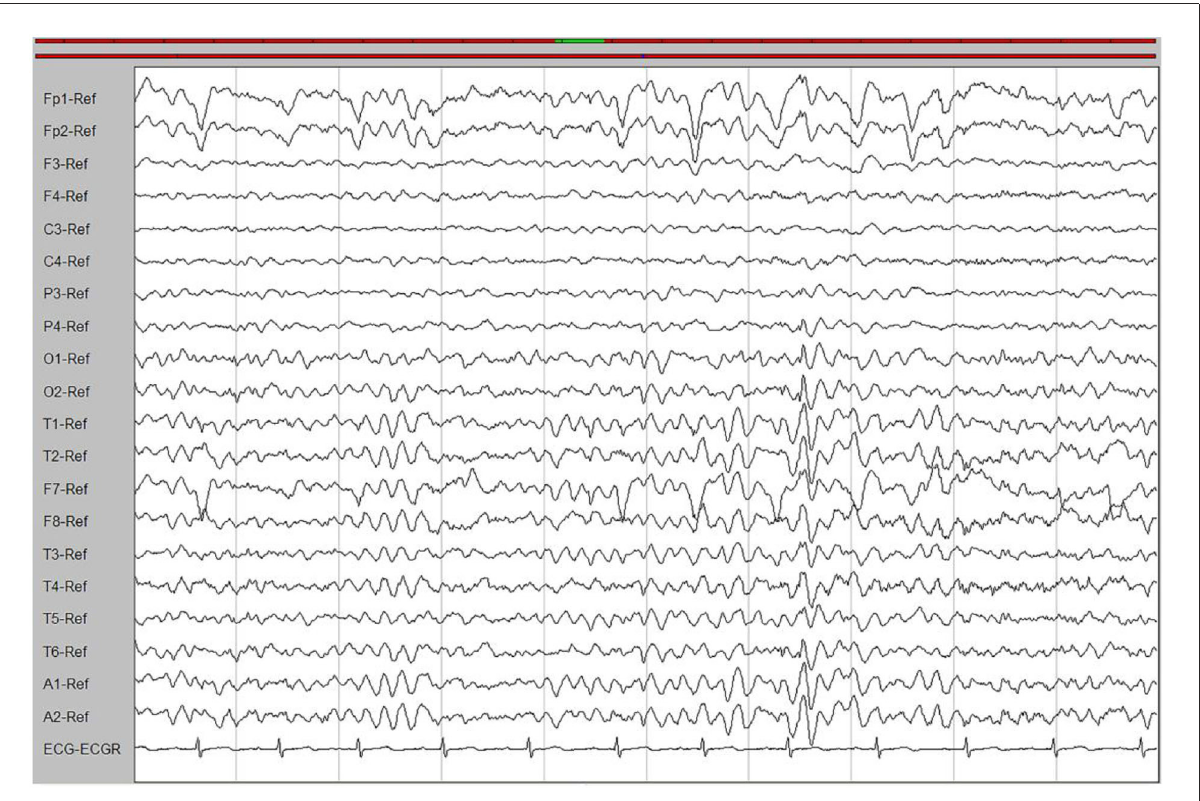
FIGURE1 An interictal electroencephalogram (EEG). The EEG showed generalized slowing waves (20–40 µ V) and theta waves (6–7 Hz).